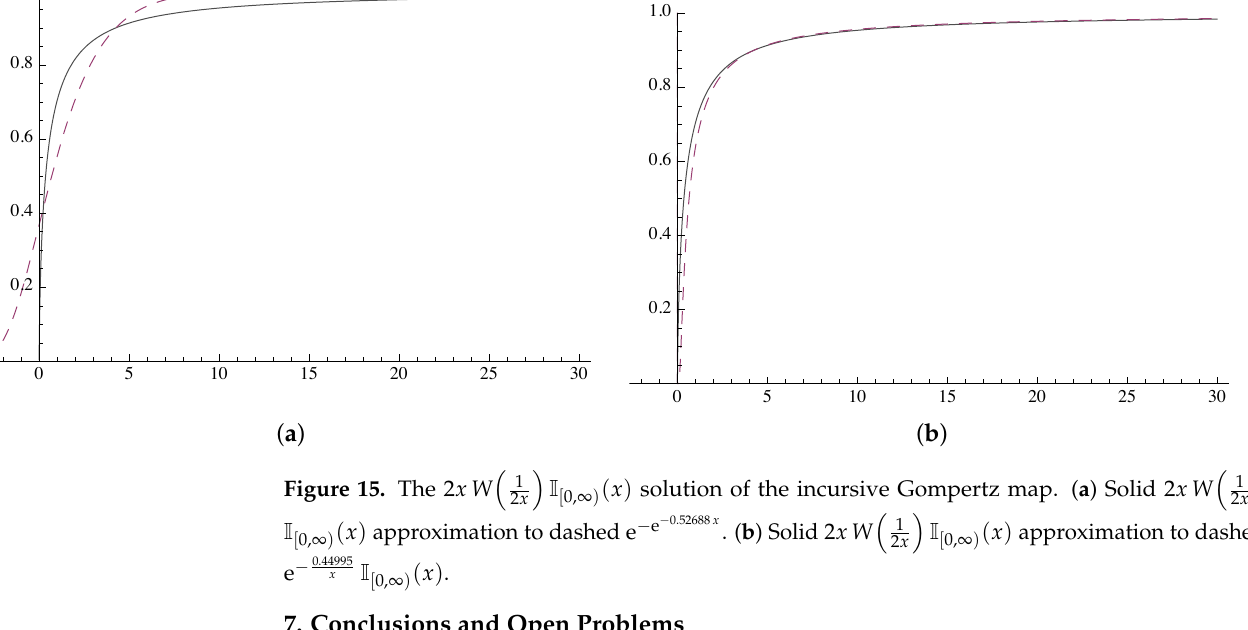
(cid:17) (cid:16) I 1 ( x ) approximation to dashed [ 0, ∞ ) 2 x